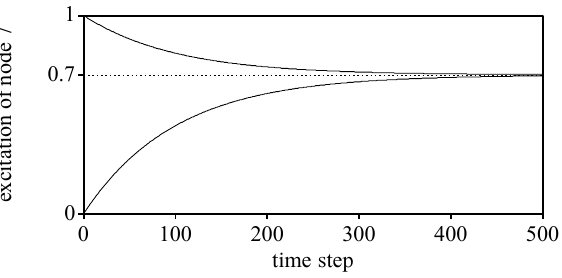
Figure 5: The time path of the excitation (and activity) of node /ampa/. Bottom curve: starting from 0. Top curve: starting from